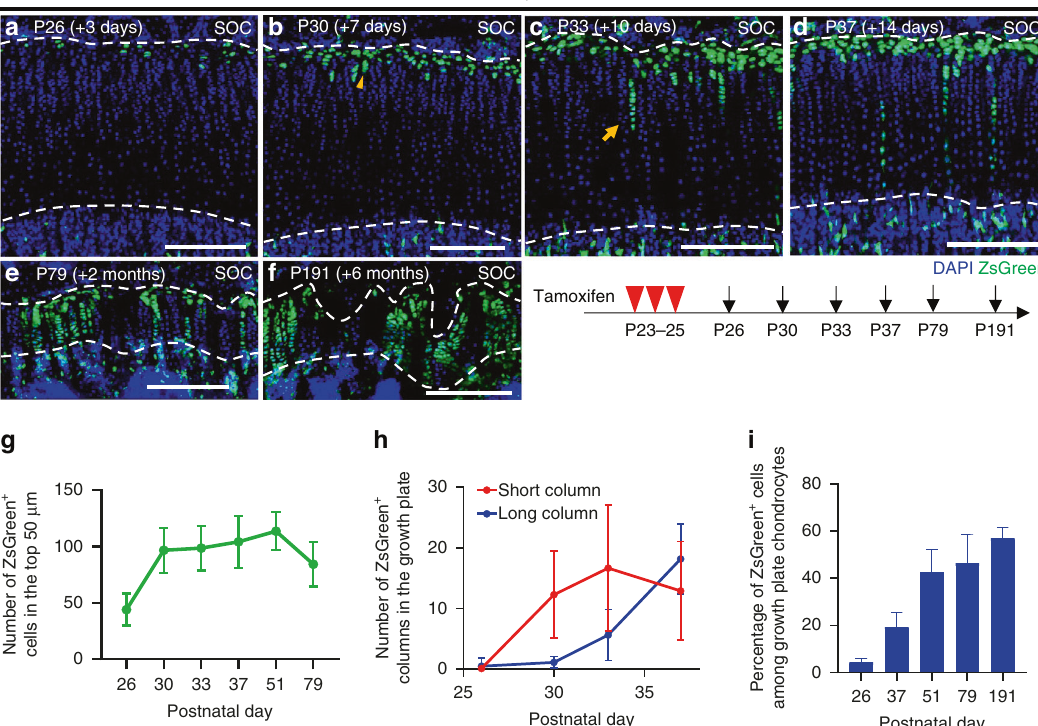
Fig. 2 Axin2 + cells include a subset of chondroprogenitors in the growth plate. a – f Fate-mapping analysis of Axin2 + cells in the proximal tibial growth plate in Axin2Cre ERT2 ;R26R ZsGreen mice (pulsed on P23 – 25 and traced for several days). Representative images showing descendants of initially labeled Axin2 + cells at 3 ( n = 8) ( a ), 7 ( n = 8) ( b ), 10 ( n = 8) ( c ) and 14 ( n = 8) ( d ) days and at 2 ( n = 7) ( e ) and 6 ( n = 6) ( f ) months after tamoxifen injection. Arrowhead, short column ( ≤ 9 cells) ( b ); arrows, long column ( ≥ 10 cells) ( c ). g – i Quanti fi cation of ZsGreen + cells in the top 50 μ m (green line) ( g ), ZsGreen + columns in the growth plate, short columns ( ≤ 9 cells, red line) and long columns ( ≥ 10 cells, blue line) ( h ), and percentage of ZsGreen + cells among growth plate chondrocytes (blue bars) ( i ). P26 – P51 ( n = 8), P79 ( n = 7), and P191 ( n = 6). SOC secondary ossi fi cation center. The white dashed lines demarcate the growth plate from the surrounding tissues. Scale bars: 200 μ m ( a – f ). All data are presented as the mean ±